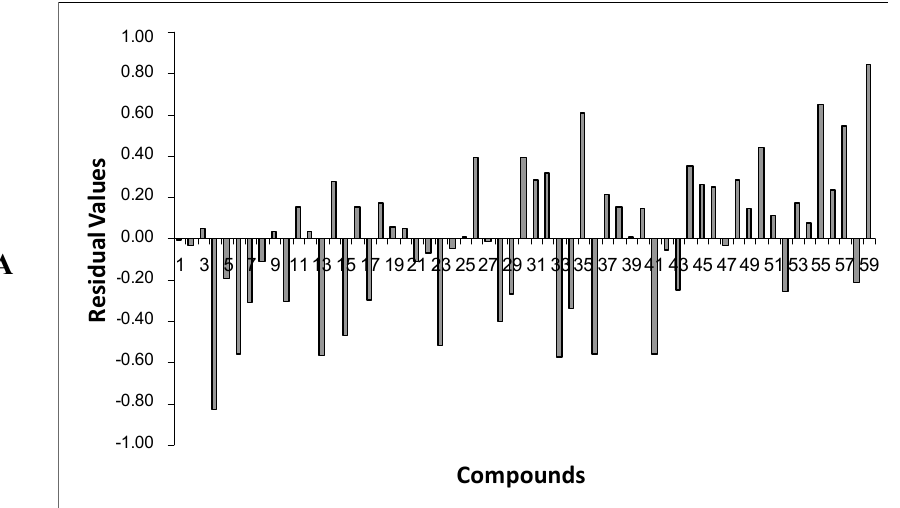
Figure 8. Residual values of compounds of the (A) training ( 1–59 ) and (B) test ( 60 – 74 ) sets according to the Eq.E (DB-I)